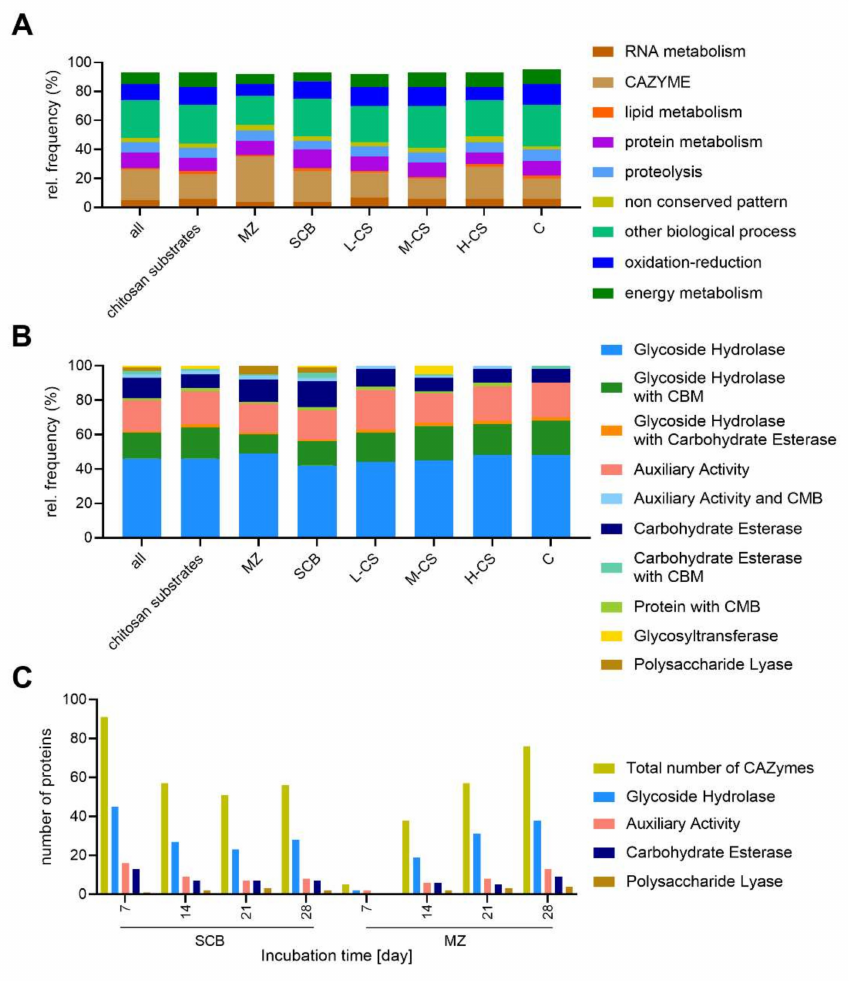
Figure 6. Number of proteins detected by the proteomic analysis of different S. longicolleum secre- tomes. Stacked bar plots are classified according to ( A ) the biological activity of all proteins, or ( B ) the distribution of CAZyme classes. ( C ) Time-course analysis of the CAZyme classes produced by SCB and